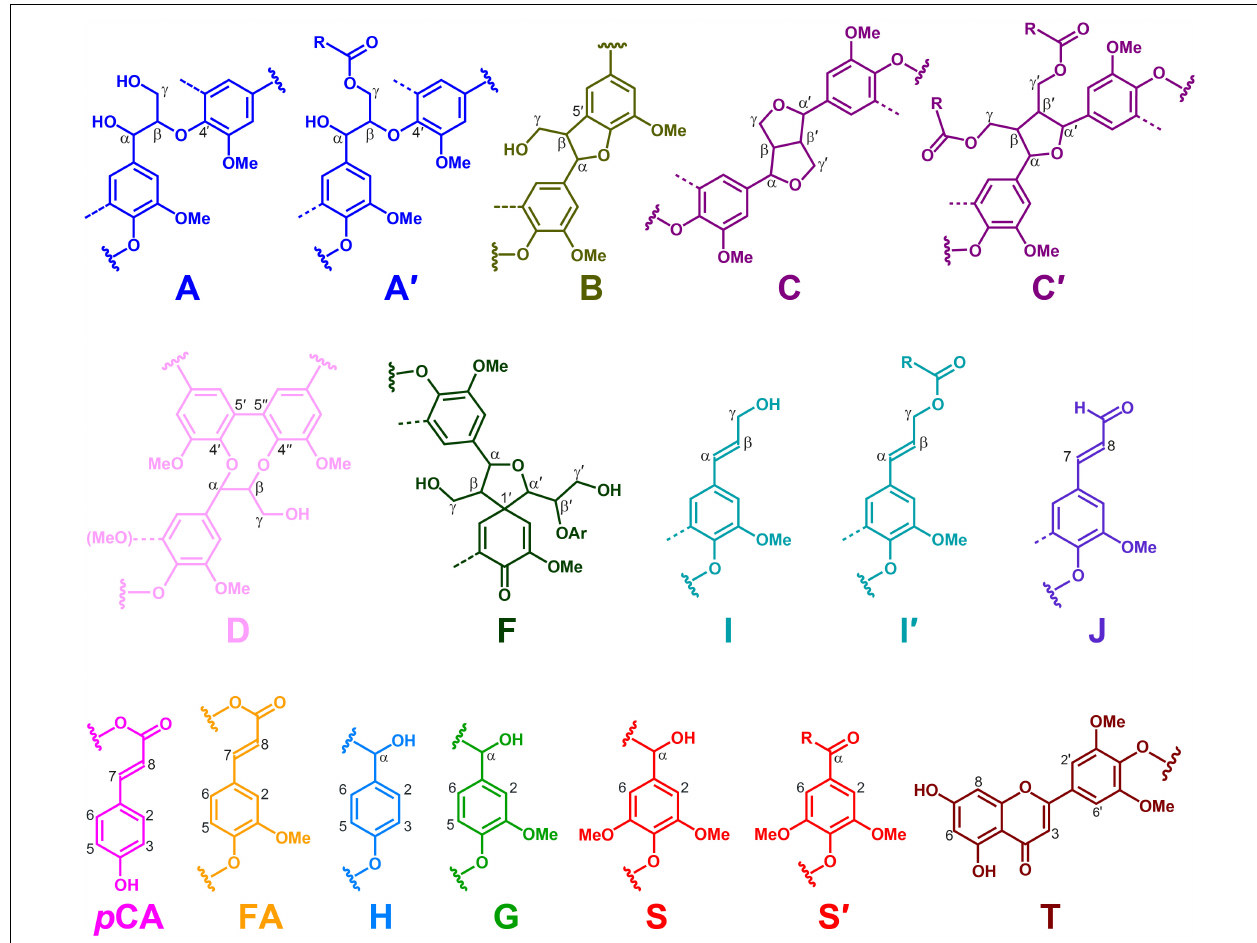
FIGURE 5 | Main structures identified in the NMR spectra of the lignins of rice husks and straw. A , β – O –4 (cid:48) alkyl-aryl ethers; A (cid:48) , β – O –4 (cid:48) alkyl-aryl ethers acylated at the γ -OH; B , phenylcoumarans; C , resinols; C (cid:48) , tetrahydrofurans acylated at the γ -OH; D , dibenzodioxocins; F , spirodienones; I , p -hydroxycinnamyl alcohol end-groups; I (cid:48) , p -hydroxycinnamyl alcohol end-groups acylated at the γ -OH; J , cinnamaldehyde end-groups; p CA , p -coumarates; FA , ferulates; H , p -hydroxyphenyl units; G , guaiacyl units; S , syringyl units; S (cid:48) , C α -oxidized S-units; T , tricin. The structures are colored in order to match the signals in the HSQC spectra of Figures 3 , 4